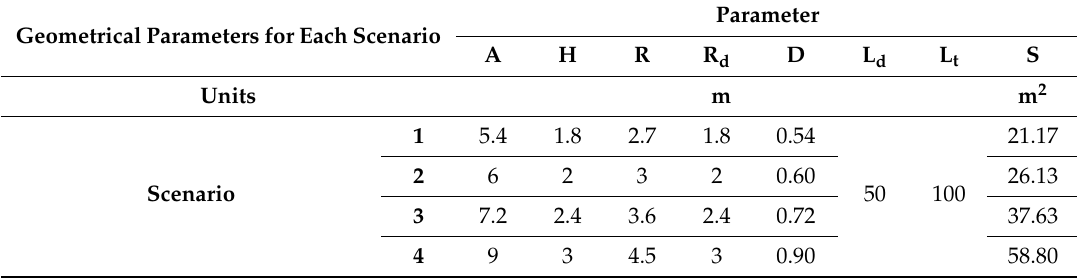
Figure 3. Definition of the parameters. Tunnel view: Left, lateral; right, front. Table 1. Geometrical parameters used for the parametric study. Table 1. Geometrical parameters used for the parametric study.